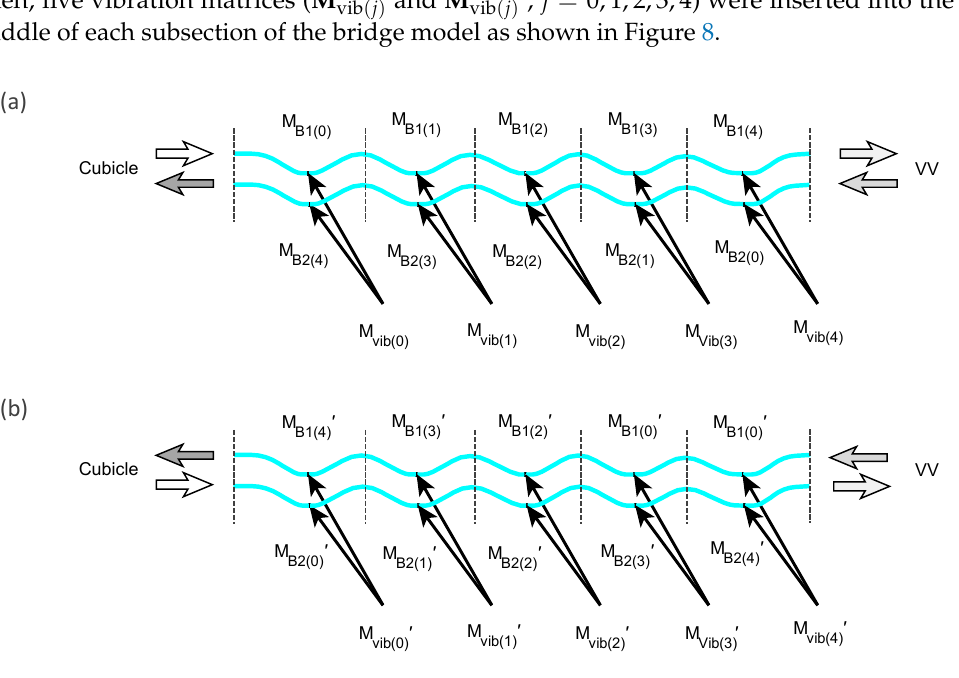
Figure 8. Modeling of the Jones matrices of spun fiber in the bridge section, including the vibration effect for ( a ) the forward propagation and ( b ) the backward